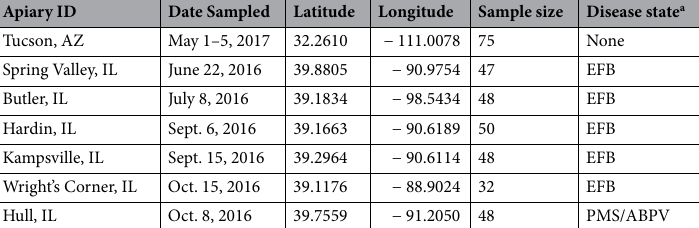
Table 1. Metadata associated with larval sampling. a EFB is European foulbrood, and PMS/ABPV is parasitic mite syndrome /acute bee paralysis